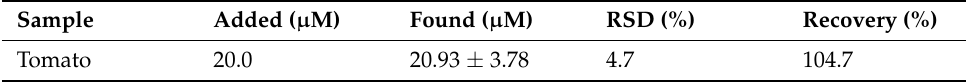
Table 3. CBZ detection in tomatoes using the proposed aptasensor (n = 3).